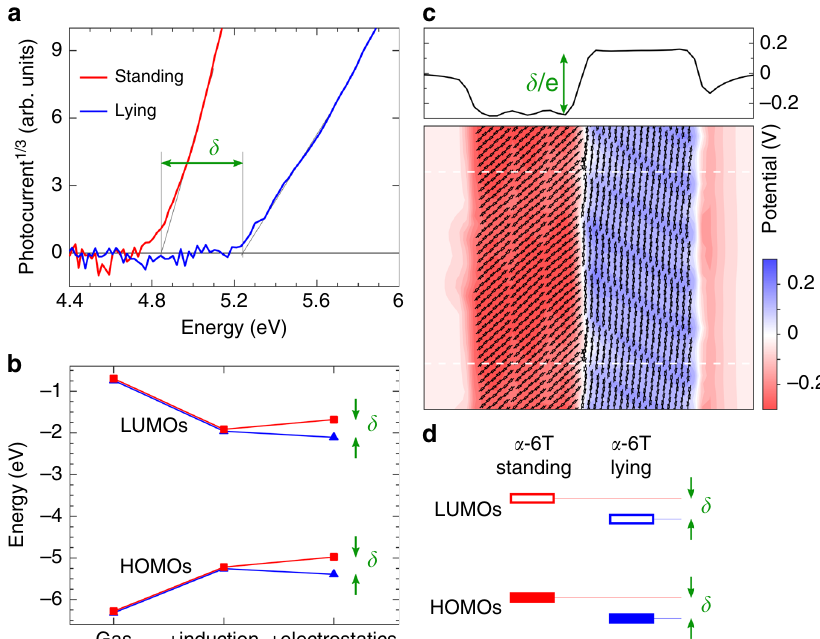
Fig. 4 Charge transport energy levels in α -6T thin fi lms. a Ambient photoemission spectroscopy (APS) results for α -6T thin fi lms with standing and lying orientations presenting an energy difference δ ~ 0.4 eV between their HOMO levels (referenced to the vacuum level). b Evolution of HOMO and LUMO levels calculated from embedded GW calculations for an interface between two domains with standing and lying α -6T molecules. Results are presented by progressively adding induction (dielectric response) and electrostatic intermolecular interactions to gas-phase levels. This shows that the offset δ between standing and lying molecules is entirely sourced by electrostatics. c Maps of the electrostatic potential illustrating the step-like variation across the standing-lying interface. d Sketch of the energy levels of standing and lying α -6T molecules, playing the role of electron donor and acceptor component,